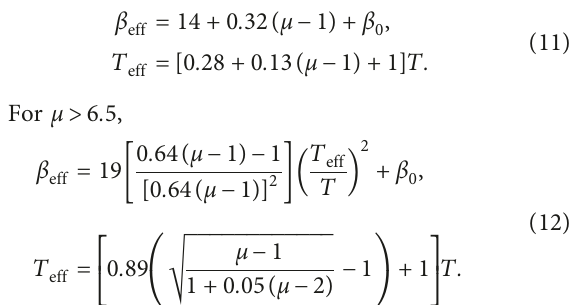
Figure 3: SDOF nonlinear system and equivalent viscous damping due to hysteretic energy